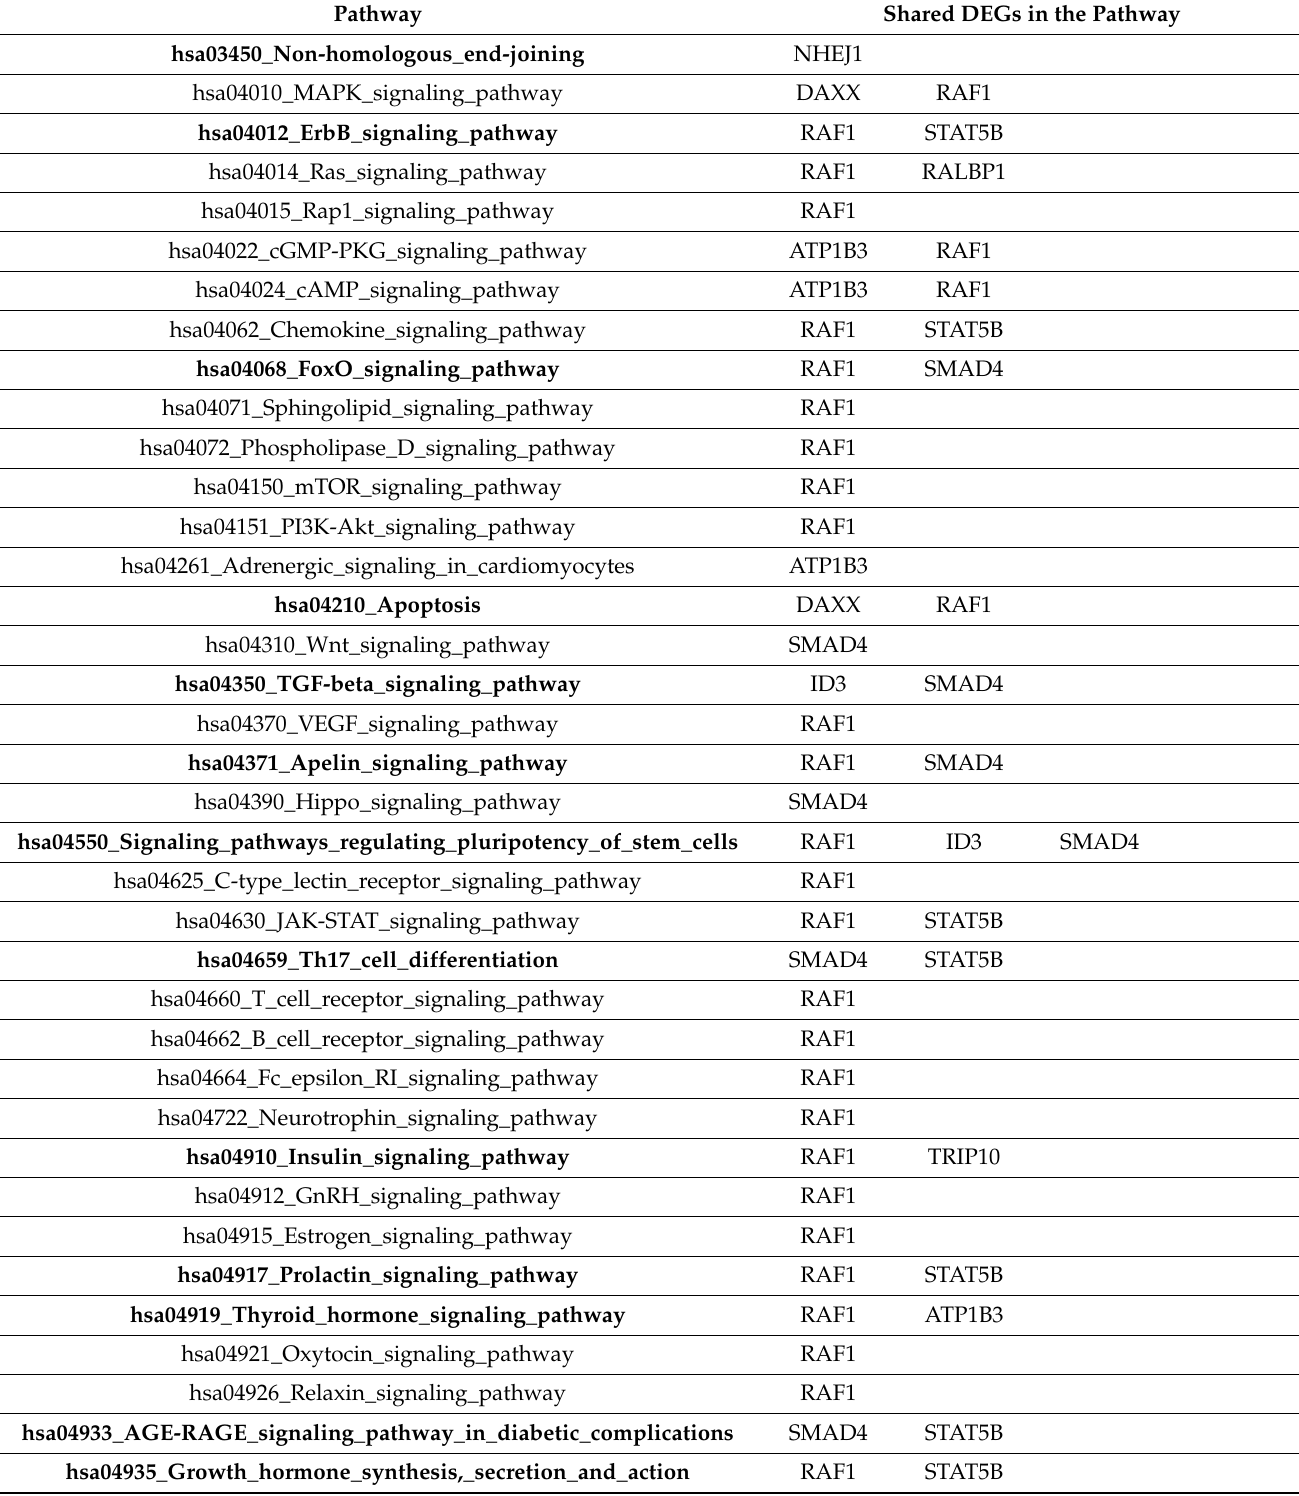
Table 3. All shared DEGs and associated pathways